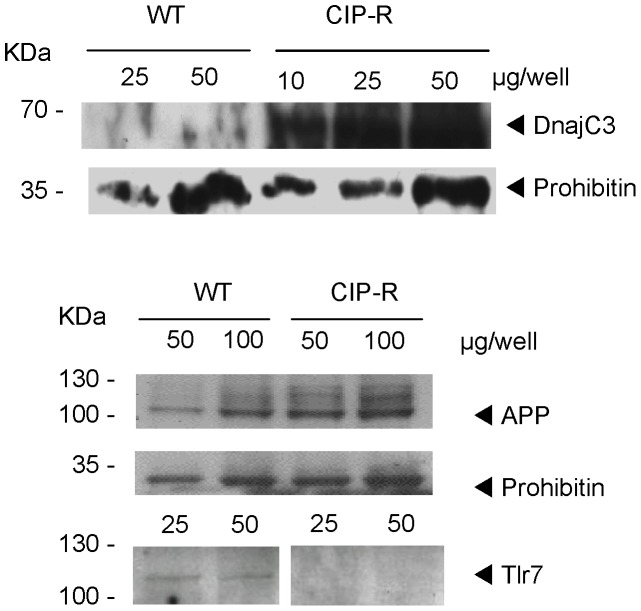
Validation by Western blot of differentially expressed proteins.Western blots of membrane proteins prepared from wild-type (WT) and ciprofloxacin-resistant (CIP-R) J774 macrophages. Gels were loaded with the indicated amounts of proteins. Top: Detection of Dnajc3 with a rabbit anti-mouse Dnajc3 polyclonal antiserum (1∶500) and prohibitin with an anti-prohibitin polyclonal antibody (1∶500) followed by the appropriate anti-IgG HRP-labeled antibodies. Bottom: Revelation of amyloid precursor protein App with a rabbit antiserum (1∶2000) and of prohibitin as loading control, followed by the appropriate anti-IgG HRP-labeled antibodies (1∶5000). For Tlr-7 detection, gels were loaded with the amounts of protein indicated and revealed with anti-Tlr7 antibody (1∶75), followed by the appropriate anti-IgG HRP-labeled antibody (1∶250).